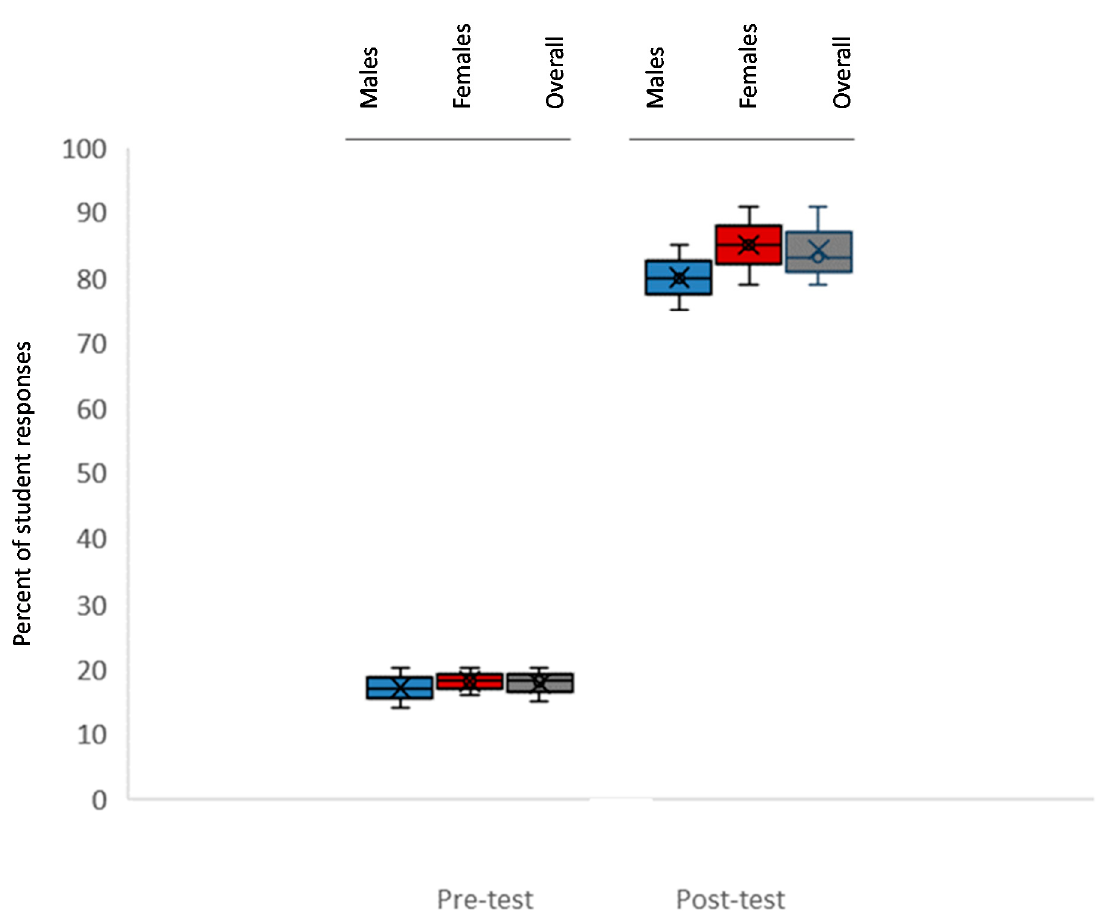
Figure 3. Percent of student responses indicating awareness of domestic violence (DV) or interpersonal violence (IPV) resources or referral information (pre- and post). Most initial responses (pre-test) indicated students were unaware of specific resources or referral (Average 18.1%), which were not sex-specific, p = 0.812. However, following the educational seminar, students who could identify the resources and referral information rose to 83%, which did not vary significantly between females and males, p = 0.566.